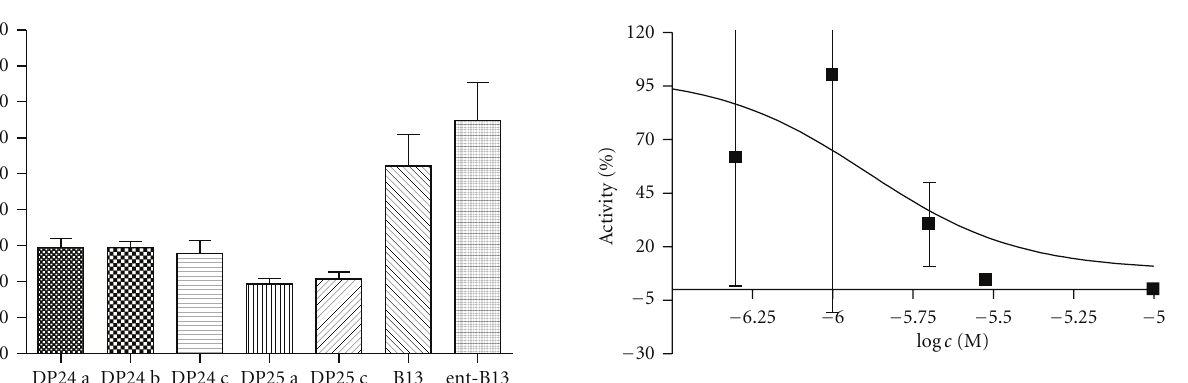
Figure 5: Activity of aCDase in the presence of 2.5 μ M of the novel analogues DP24 a–c and DP25 a,c as well as B13 and its enantiomer ent-B13. All experiments were conducted as triplicates and repeated at least once. P -values (two-tailed, in order of appearance): .007, .003, .083, .006, .009, .027, .026.